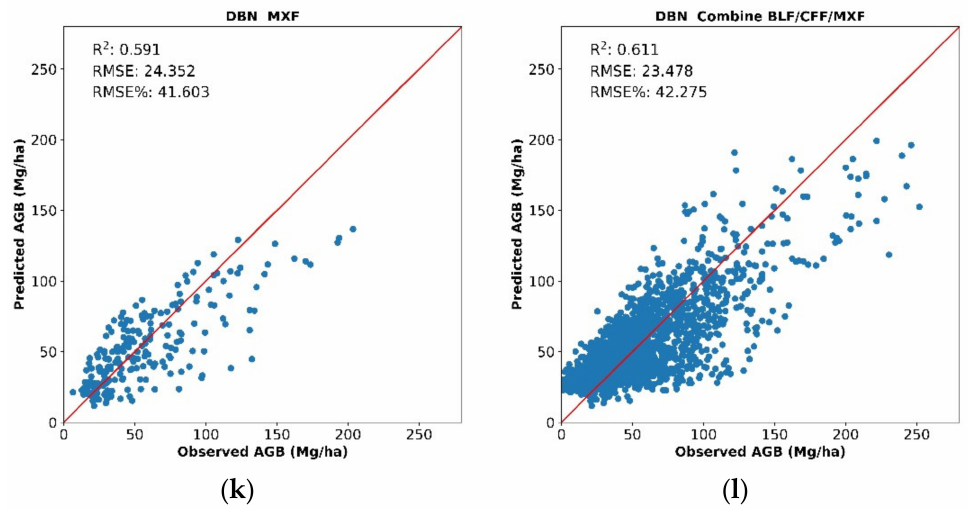
Figure 7. The performance of all models(( a ):LR BLF, ( b ):LR CFF, ( c ):LR MXF, ( d ):LR Combine BLF/CFF/MXF, ( e ): RF BLF, ( f ): RF CFF, ( g ): RF MXF, ( h ): RF Combine BLF/CFF/MXF, ( i ): DBN BLF, ( j ): DBN CFF, ( k ): DBN MXF, ( l ): DBN Combine